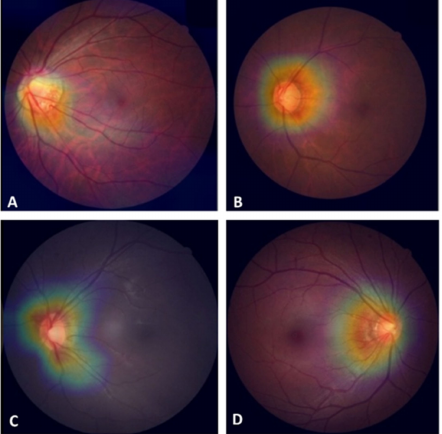
Figure 4. Gradient-weighted class activation mapping (Grad-CAM) identifying features extracted for classification in the Taipei Veterans General Hospital (TVGH) model. The hot spots (red color) were localized at the optic nerve head, with some extending to the peripapillary nerve fiber bundles in both glaucoma ( A , B ) and healthy eyes ( C , D